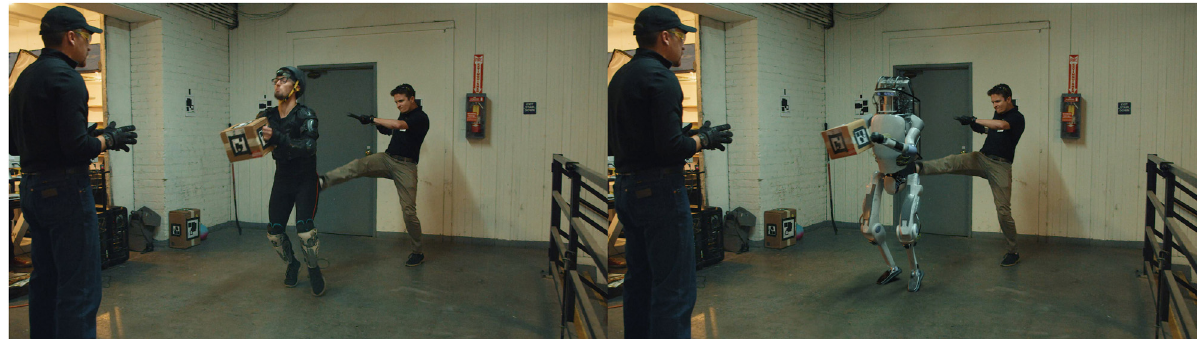
Figure 1: Kicking a human and a robot in the